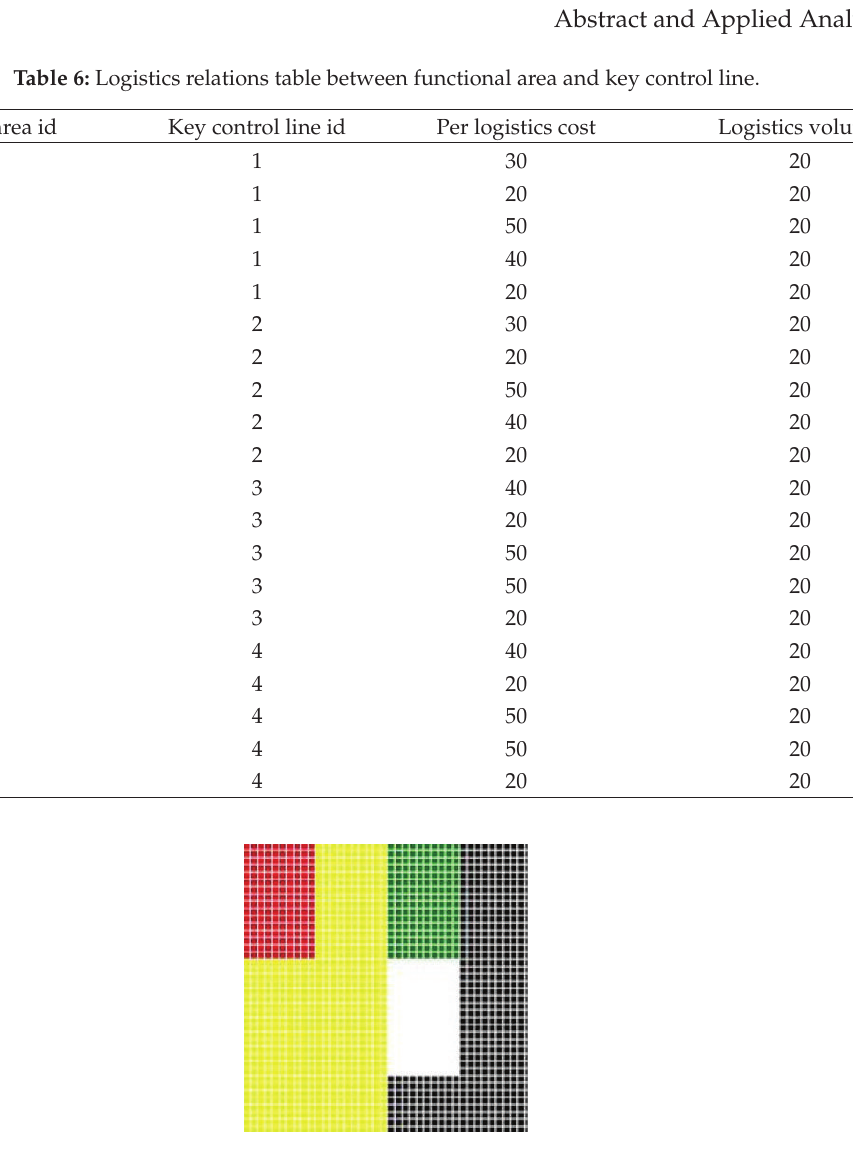
Figure 2: The initial solution got by ALDEP.